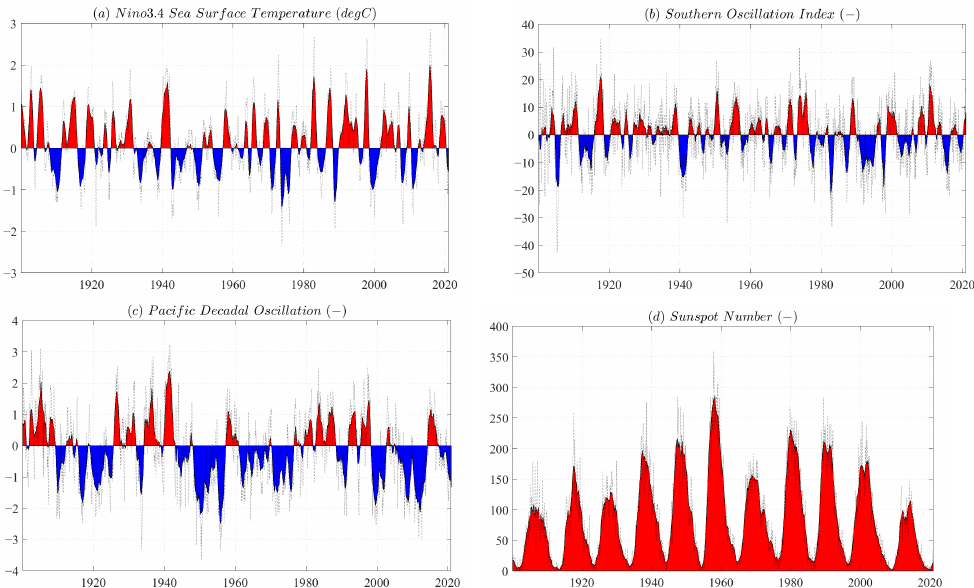
Figure 2. Monthly time series of teleconnection indexes. ( a ) Nino3.4 Sea Surface Temperature index (Nino3.4 SST); ( b ) Southern Oscillation Index (SOI); ( c ) Pacific Decadal Oscillation (PDO); ( d ) Sunspot Number (SSN). Red signifies positive value, bule signifies negative